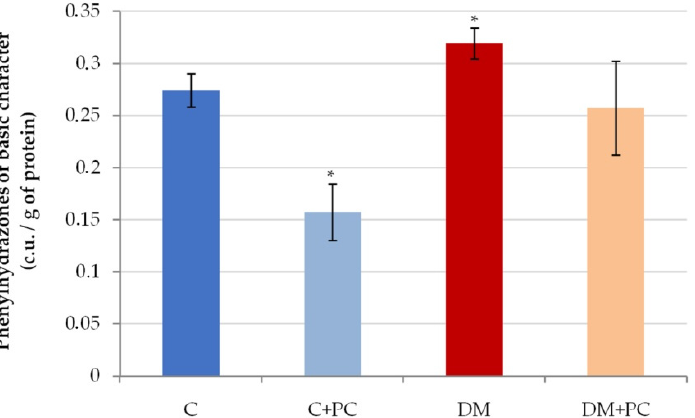
Figure 10. The content of proteins oxidative modification products of basic character (430 nm) in plasma of control rats, rats with experimental diabetes mellitus, with and without PC concentrate. C–normal untreated control animals; C + PC–animals that were per os administrated PC concentrate (daily dose of 45 mg/kg bw of polyphenolic complex for 14 days); DM–rats with experimental diabetes mellitus; DM + PC–animals with experimental diabetes mellitus that were per os administrated PC concentrate (daily dose of 45 mg/kg bw of polyphenolic complex for 14 days). *-significant difference compared to control ( p < 0.05).